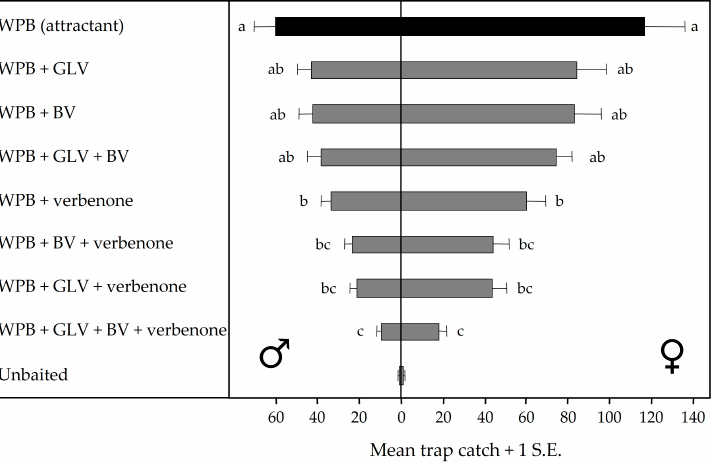
Figure 6. Daily captures of western pine beetle ( Dendroctonus brevicomis ) in multiple-funnel traps baited with an attractant (WPB), or with an attractant and green leaf volatile blend (GLV), bark volatile blend (BV), nonhost angiosperm volatile blend (GLV + BV), and verbenone, California. Bars preceded (for males) and followed (for females) by the same letter are not significantly different ( n = 30; Tukey’s HSD; p > 0.05). Adapted from Fettig et al. [42].